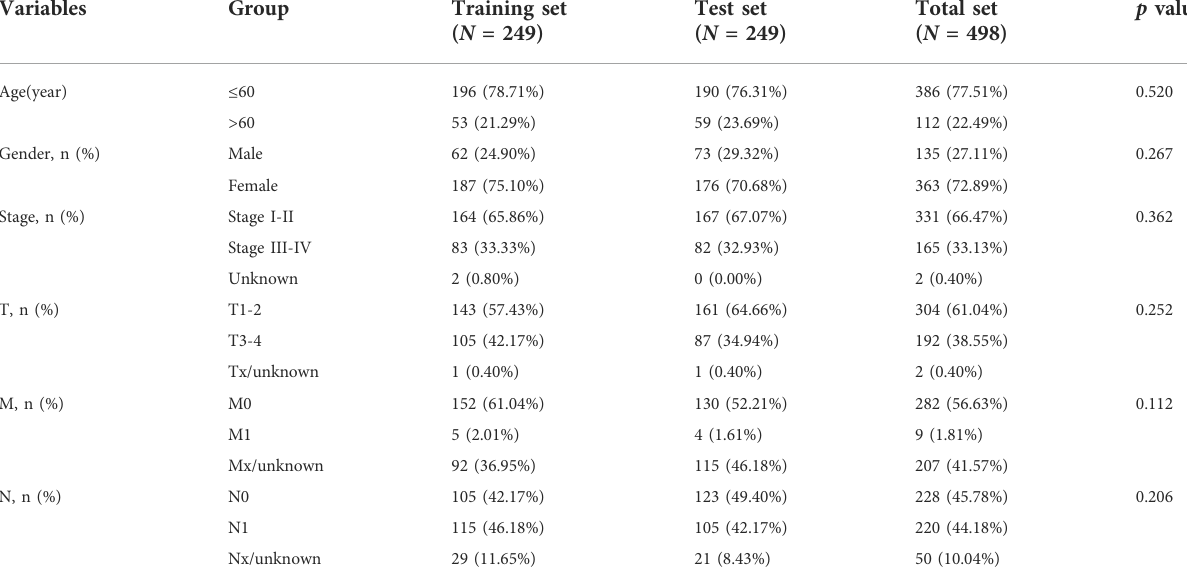
TABLE 1 The clinical characteristics in training, test, and total